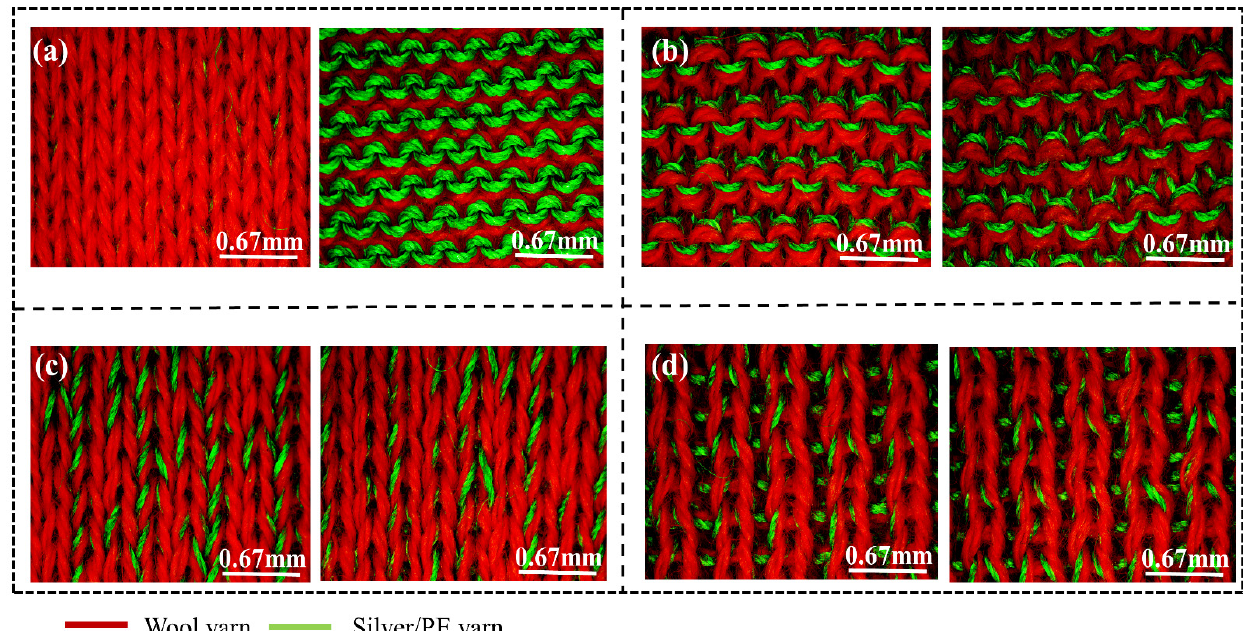
Figure 2. Fabric image, ( a ) Plain, ( b ) Purl, ( c ) Interlock, and ( d ) Rib.